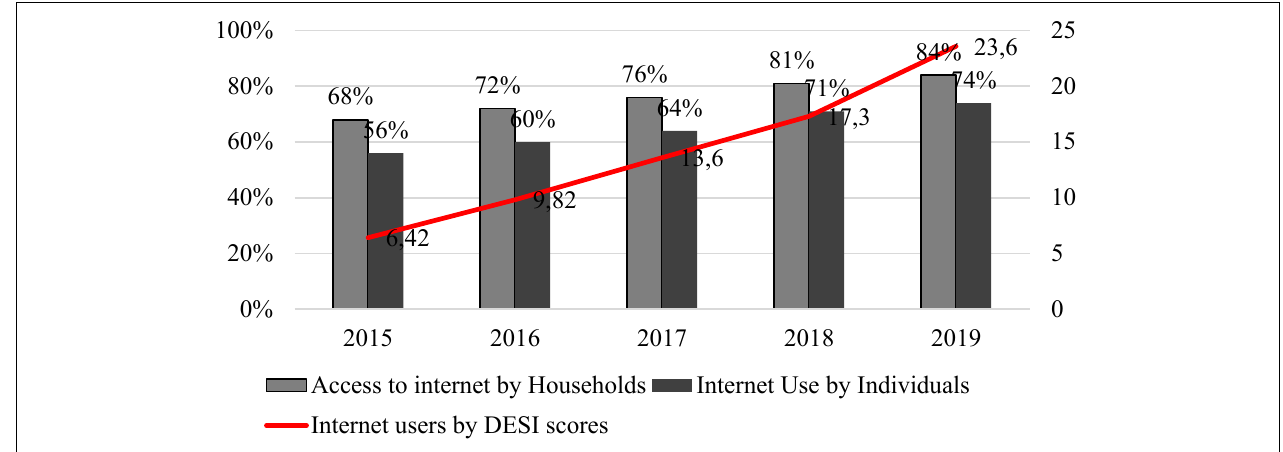
FIGURE 1 | Internet penetration in Romania in the last 5 years (DESI, 2018a; Eurostat, 2020). The Digital Economy and Society Index (DESI) is a composite index that summarizes relevant indicators on Europe’s digital performance and tracks the evolution of EU Member States in digital competitiveness. DESI Indicators: connectivity, human capital, use of internet services, integration of digital technology, digital public services (DESI,